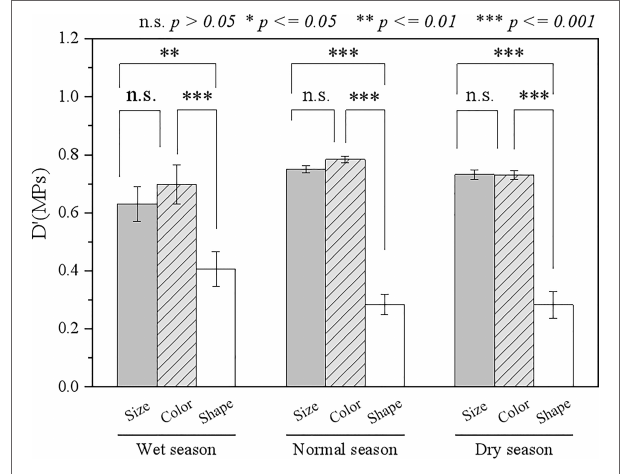
FIGURE 5 | Seasonal diversity variation of MPs from land-based sources in